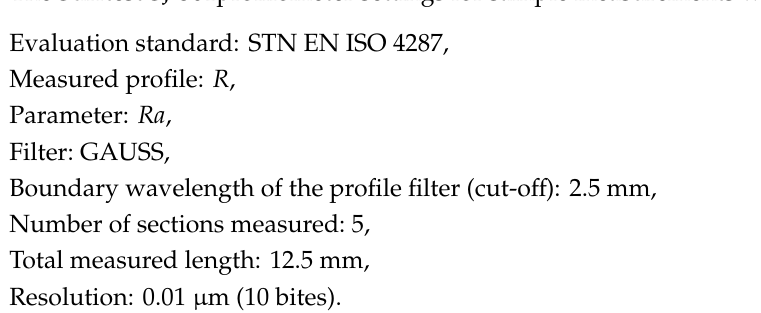
Figure 3. Measurement of the parameter of interest: ( a ) Position of the sample on a metal plate; ( b ) measuring the surface roughness at the center of the sample cut surface (detail).